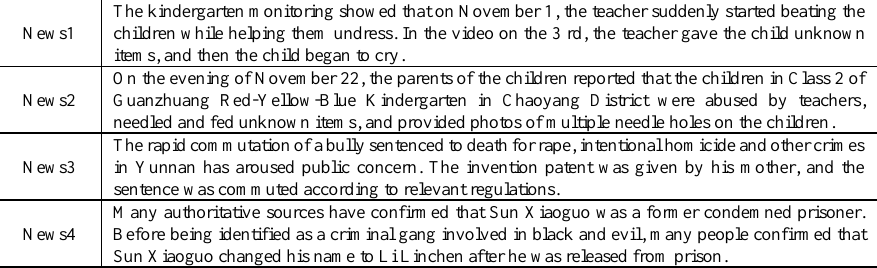
Figure 1. Examples of Case-Involved